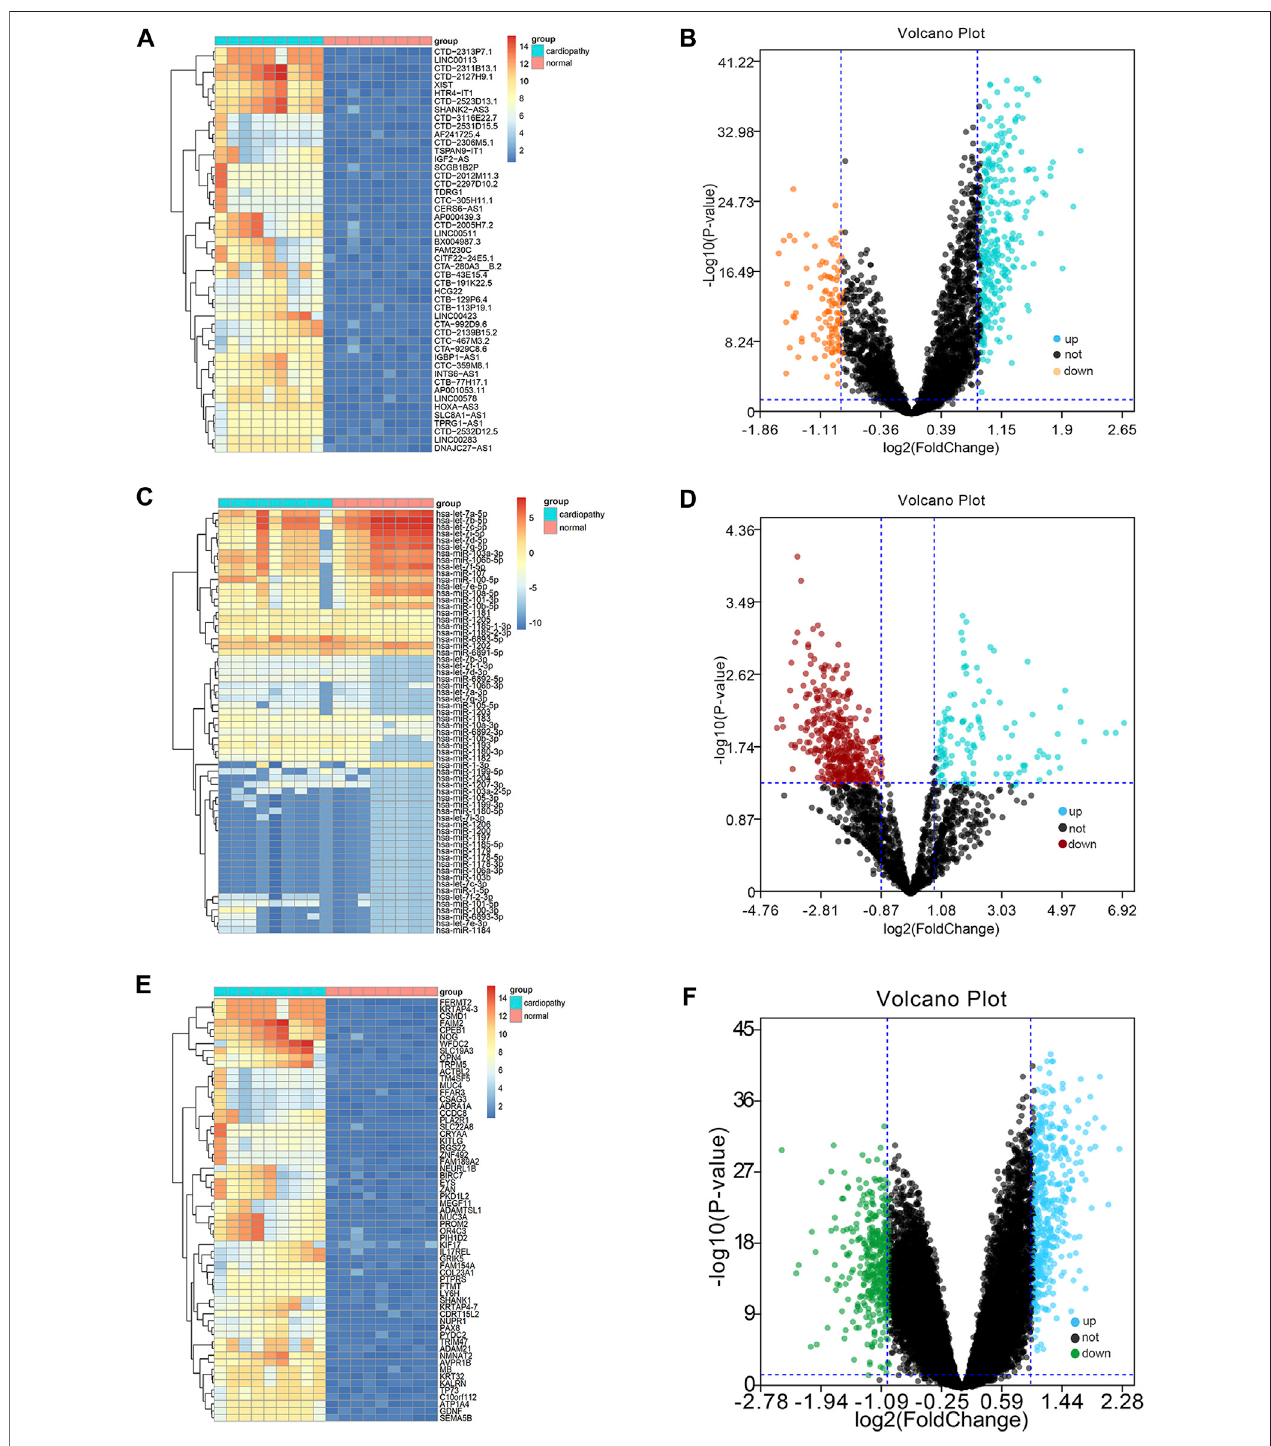
FIGURE 1 | Differential micro RNA (miRNA)-long non-coding RNA (lncRNA)-messenger RNA (mRNA) group analysis. Integrated data for miRNA-lncRNA-mRNA differential analysis show the results in a volcano plot and heat map ( Figures 1A – F ); the miRNA-lncRNA-mRNA differential heat map shows the results ( Figures 1A, C, E ); the miRNA-lncRNA-mRNA differential volcano plot shows the results ( Figures 1B, D, F ).